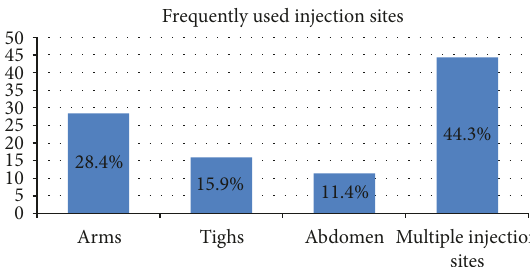
Figure 1: Frequently used insulin injection site among study